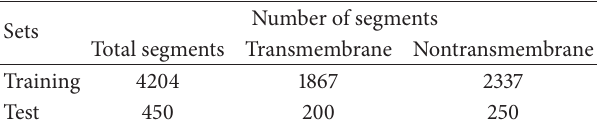
Table 1: Training and test sets.